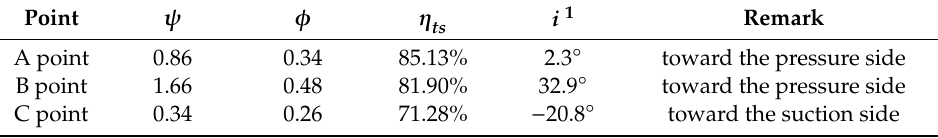
Table 8. Information on the main points of the performance curves according to dimensionless variables. Point ψ